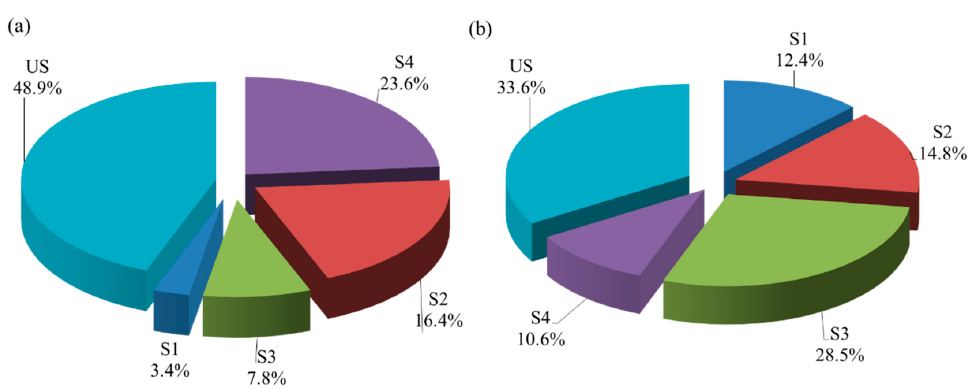
Figure 5. Average contributions of pollution sources to the water quality based on the APCS-MLR model in the LP ( a ) and HP ( b ) zones. The S1, S2, S3, S4, and US in the LP zone were identified as point source pollution of petrochemical sewage, non-point sources pollution from agricultural activity, pollution source of fecal matter, point source pollution of domestic sewage, and one undefined source, respectively. The S1, S2, S3, S4, and US in the HP zone were identified as point source pollution of hybrid wastewater discharged, non-point source of pollution of overland runoff, point source pollution of domestic sewage, point source pollution of industrial sewage, and one undefined source,